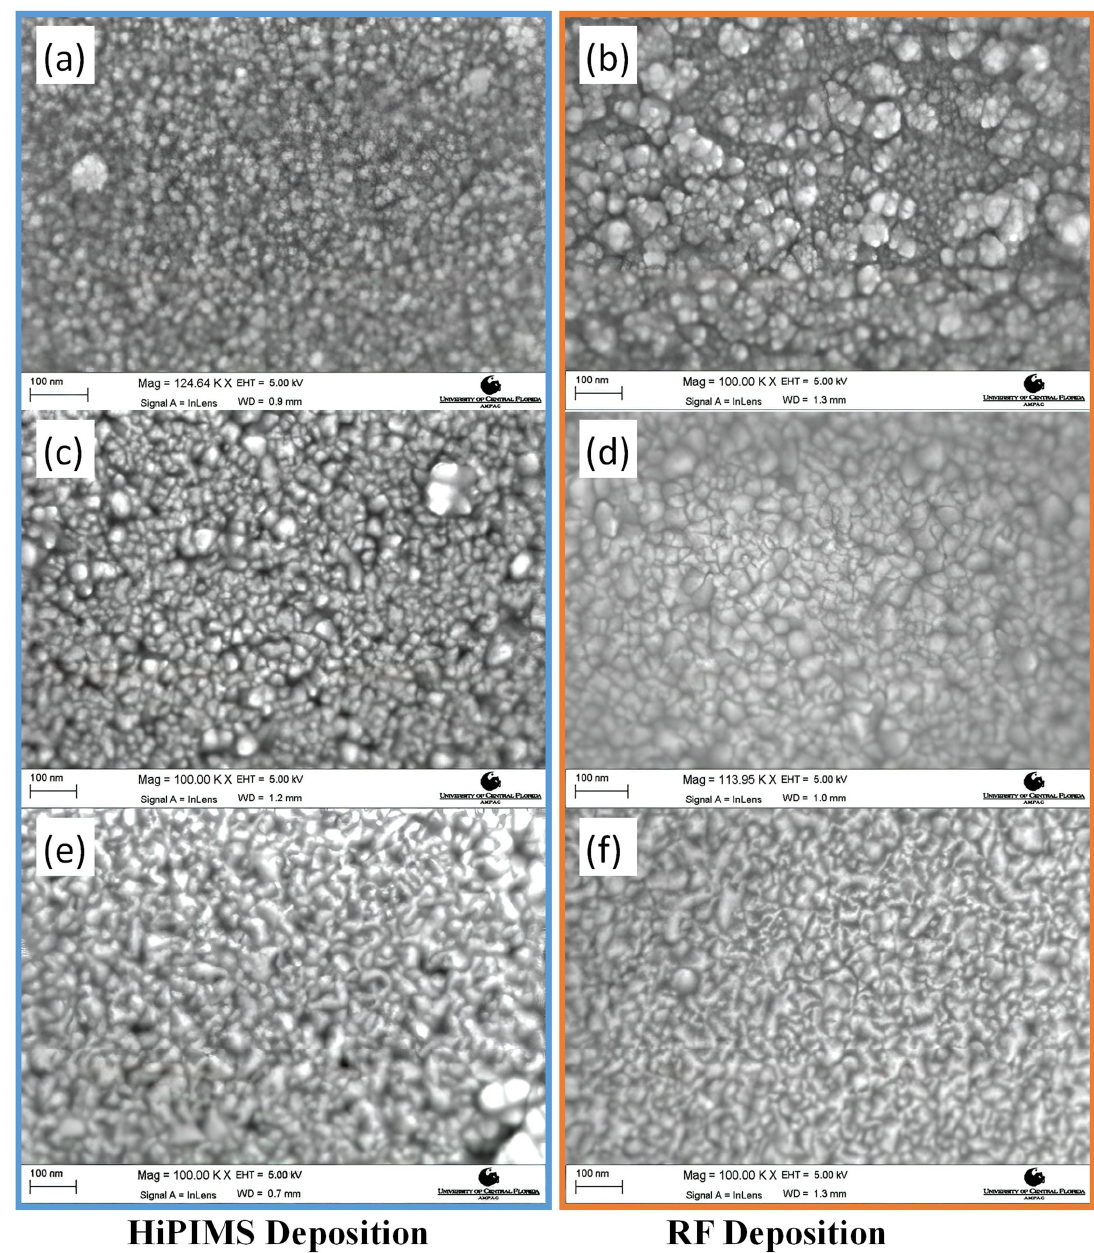
Figure 3. SEM images of the investigated depositions. ( a ): 50 W HiPIMS, ( b ) 50 W RF, ( c ) 100 W HiPIMS, ( d ) 100 W RF, ( e ) 150 W HiPIMS, ( f ) 150 W RF.